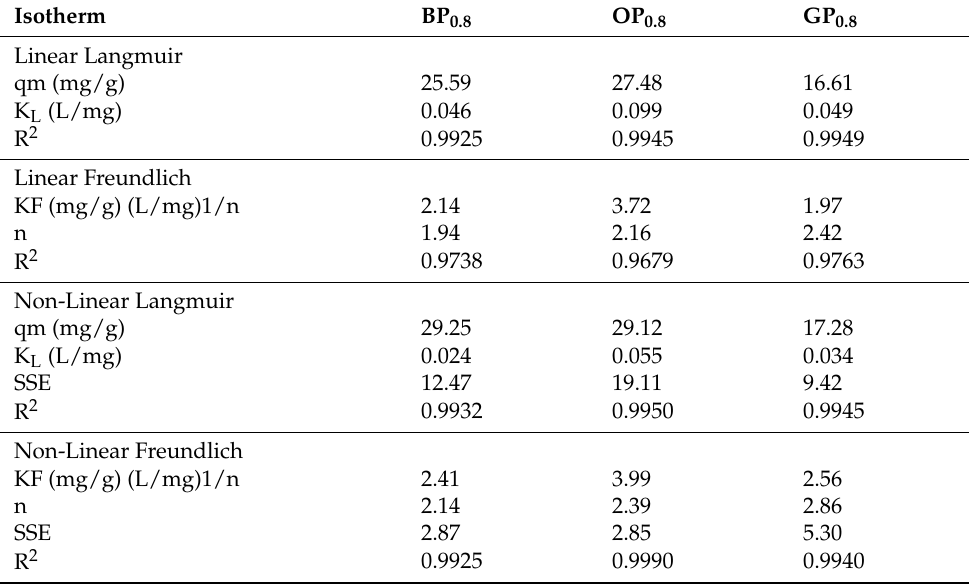
Table 4. Linear and non-linear adsorption isotherm parameters for the Zn(II) ions removal using the